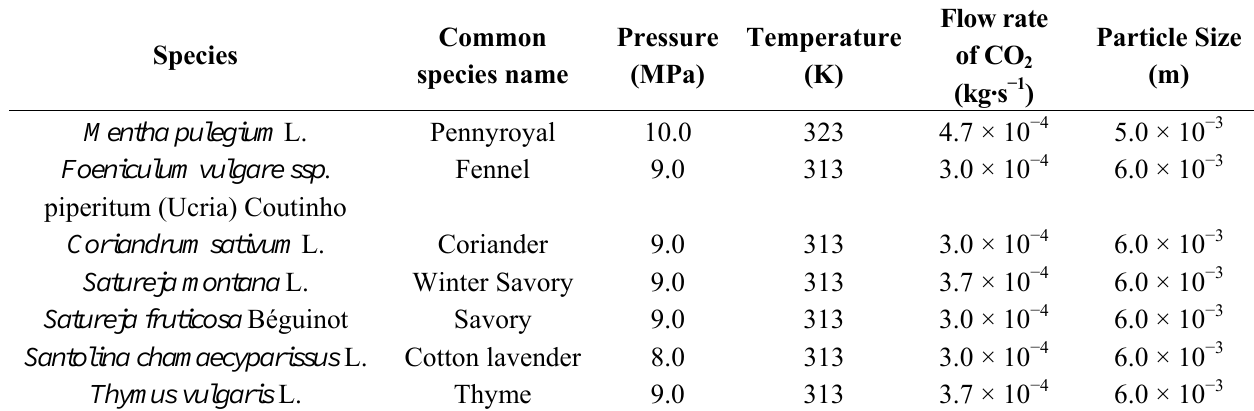
Table 1. SFE conditions of the volatile oils obtain from different plants